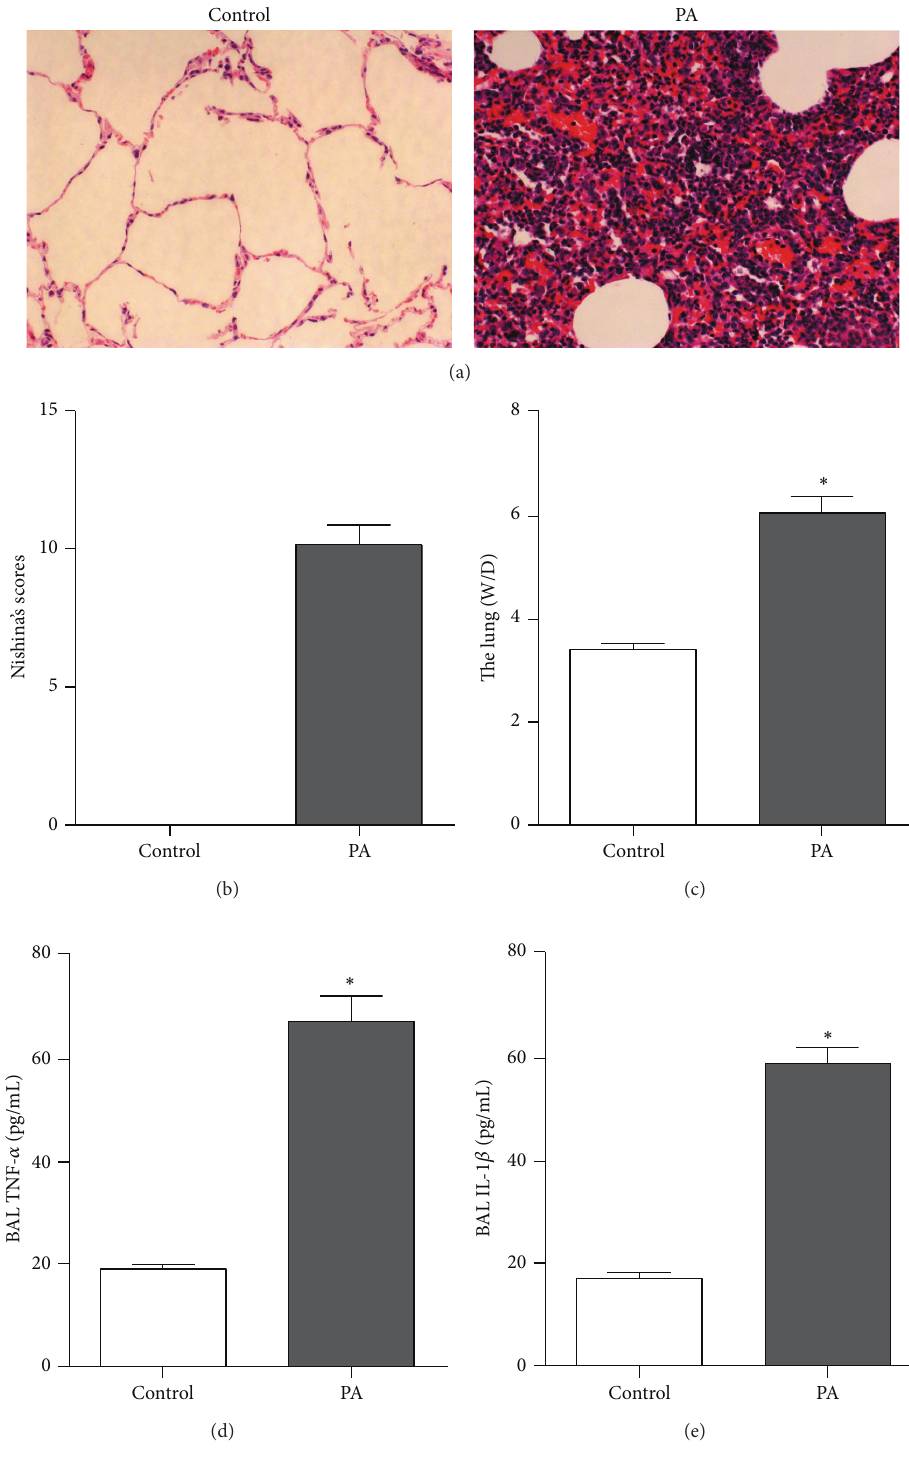
Figure 1: The establishment of the P. aeruginosa- (PA-) induced acute lung injury rat model. (a) Representative hematoxylin-eosin-stained lung tissue from the rats. Rats subjected to P. aeruginosa showed evidence of extensive lung injury with hemorrhage, inflammatory cell infiltration, and interstitial and alveolar edema compared with control conditions. Lung injury score (b), the lung W/D ratio (c), BALF TNF- 𝛼 , and IL-1 𝛽 ((d) and (e)) concentration were significantly increased in P. aeruginosa ALI rats as compared to control rats. 𝑛 = 8 rats/group. ∗ 𝑃 < 0.05